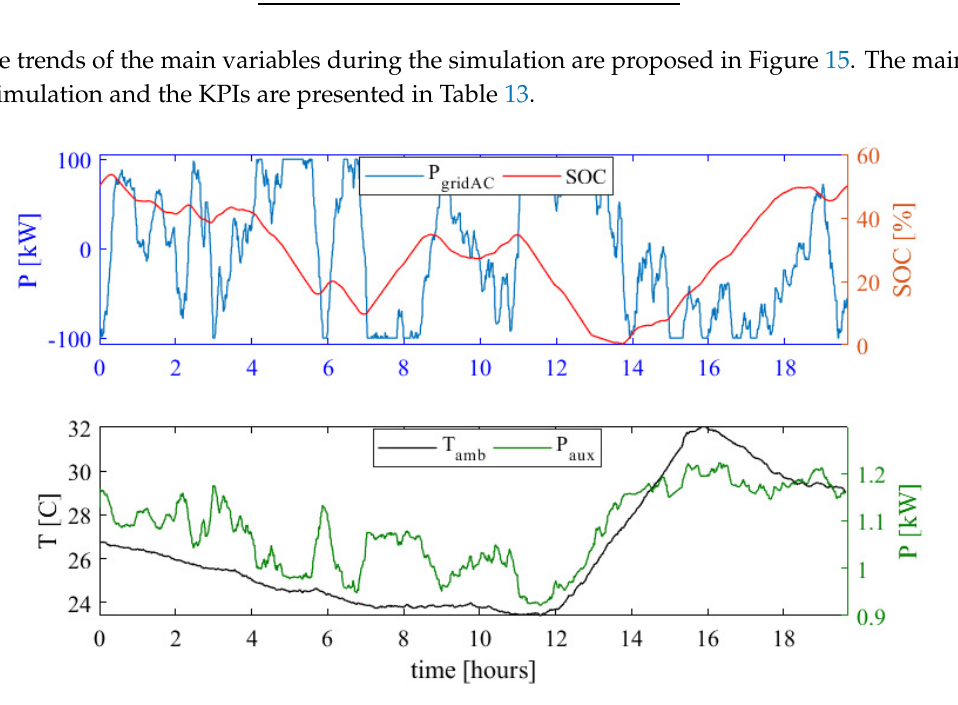
Figure 15. Simulation of aFRR provision on the Italian ancillary services market (ASM). Table 13. Summary of the results of aFRR